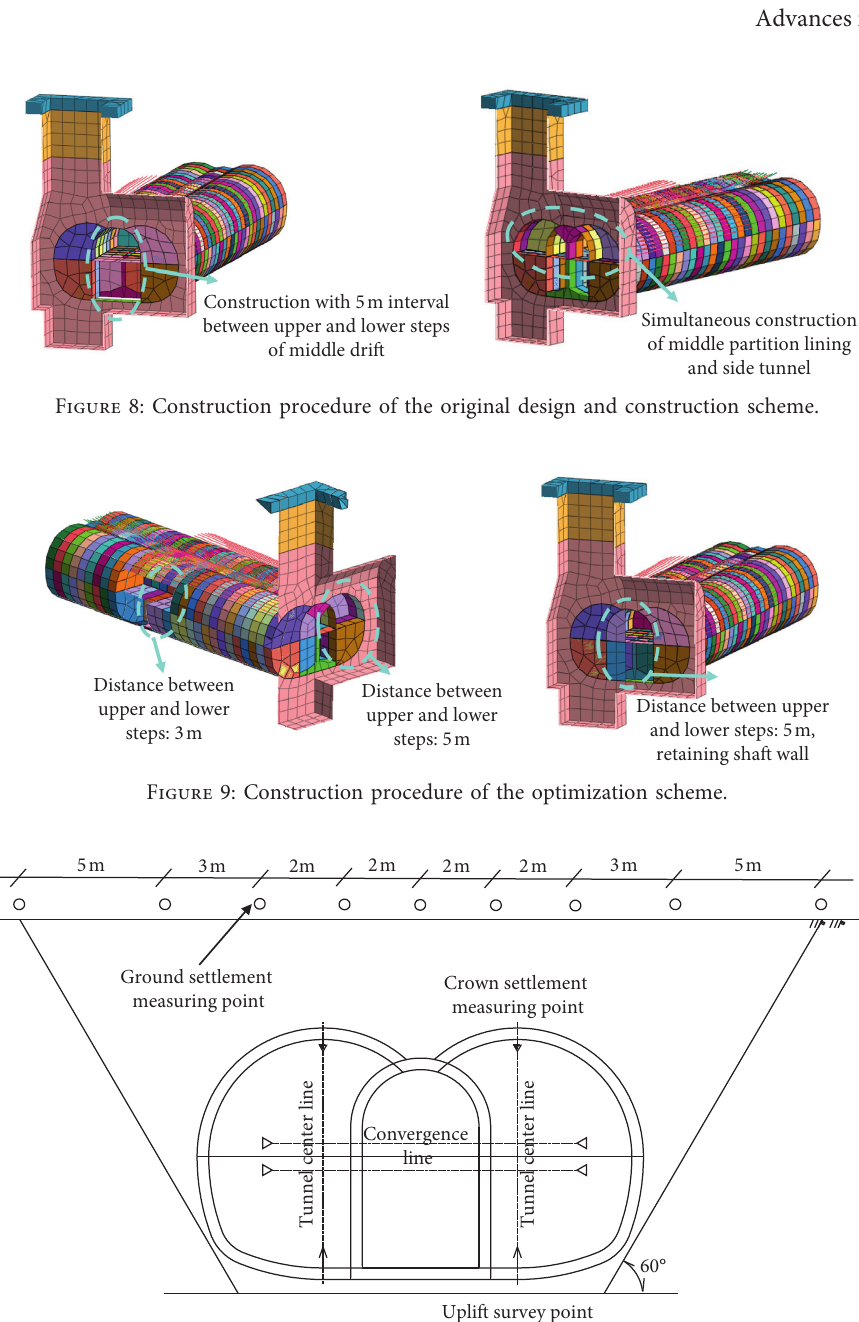
Figure 10: Section layout of underground excavation monitoring